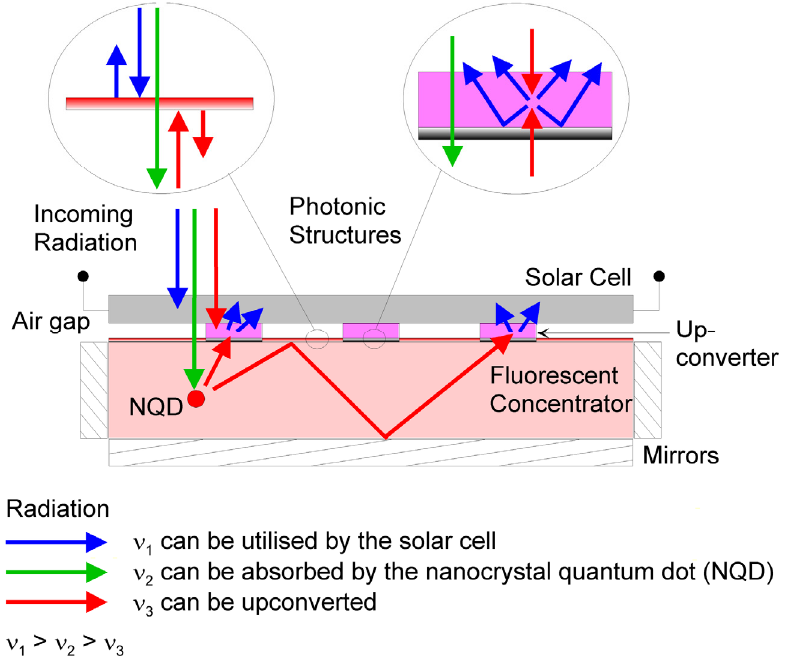
Figure 9: Setup of an advanced upconverter system. The solar cell absorbs photons with energies above the band-gap ( ν ). Photons with less energy are transmitted ( ν , ν ). The 1 2 3 upconverter transforms especially low energy photons ( ν ) into high energy photons that 3 can be used by the solar cell ( ν ). Photons with energies below the band-gap but above the 1 absorption range of the upconverter ( ν ) are absorbed by a fluorescent concentrator, which 2 emits photons in the absorption range of the upconverter ( ν ). The emitted radiation is 3 guided by total internal reflection and/or photonic structures to the upconverter. As the upconverter does not cover the whole area, a geometric concentration is achieved. Radiation which is emitted from the upconverter towards the fluorescent concentrator is back reflected by a spectrally selective photonic structure